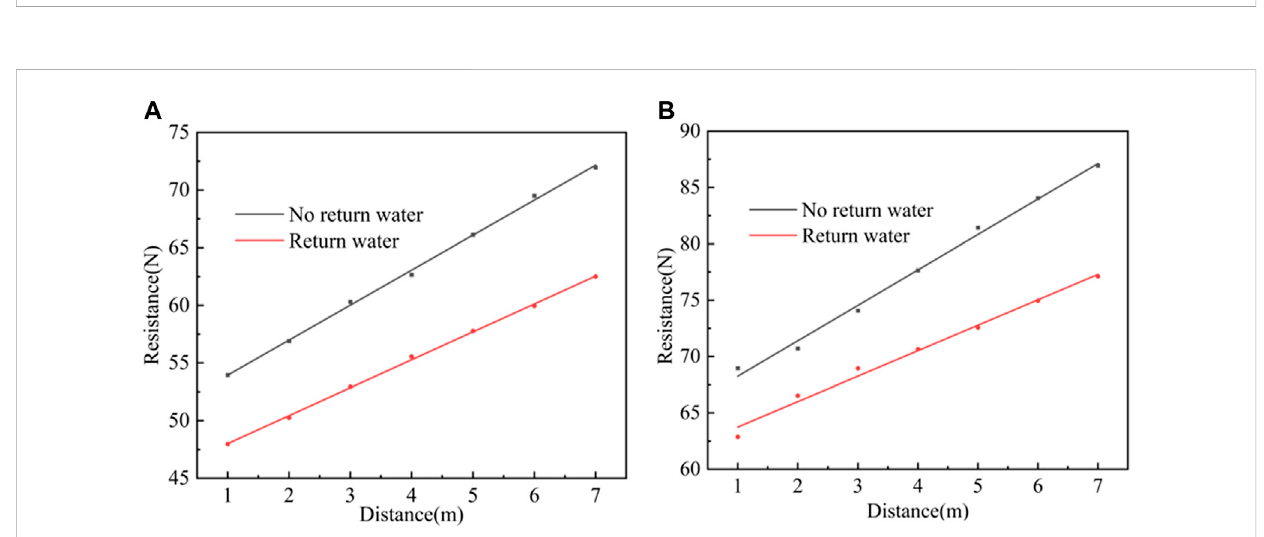
FIGURE 6 The effect ofreturn water on resistance (A) The effect ofreturnwater onresistance at10 MPa (B) The effect ofreturnwater on resistance at15 MPa.